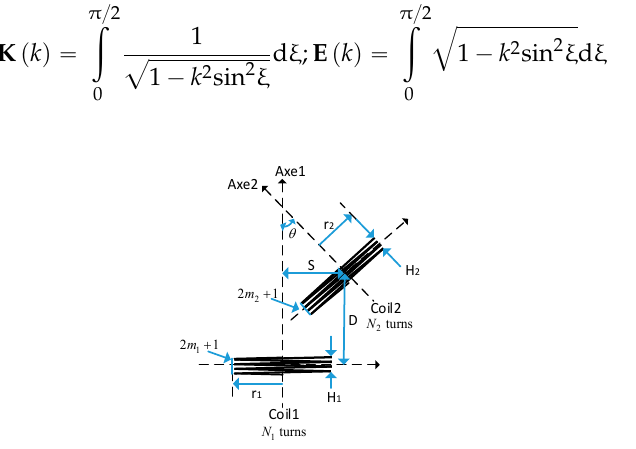
Figure 3. Schematic of two coils for mutual inductance calculation.